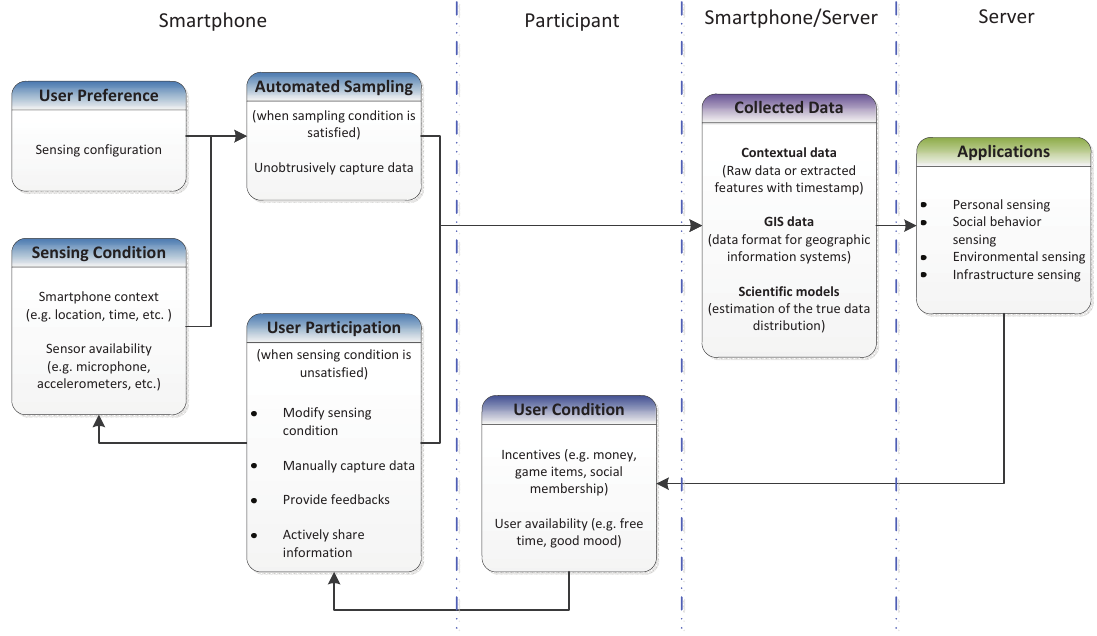
Figure 3. Common architecture for participatory